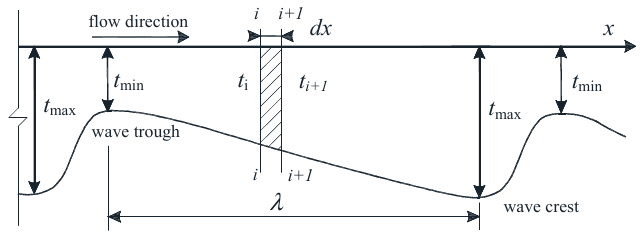
Figure 6. Schematic diagram of the thickness and length of an ice wave.